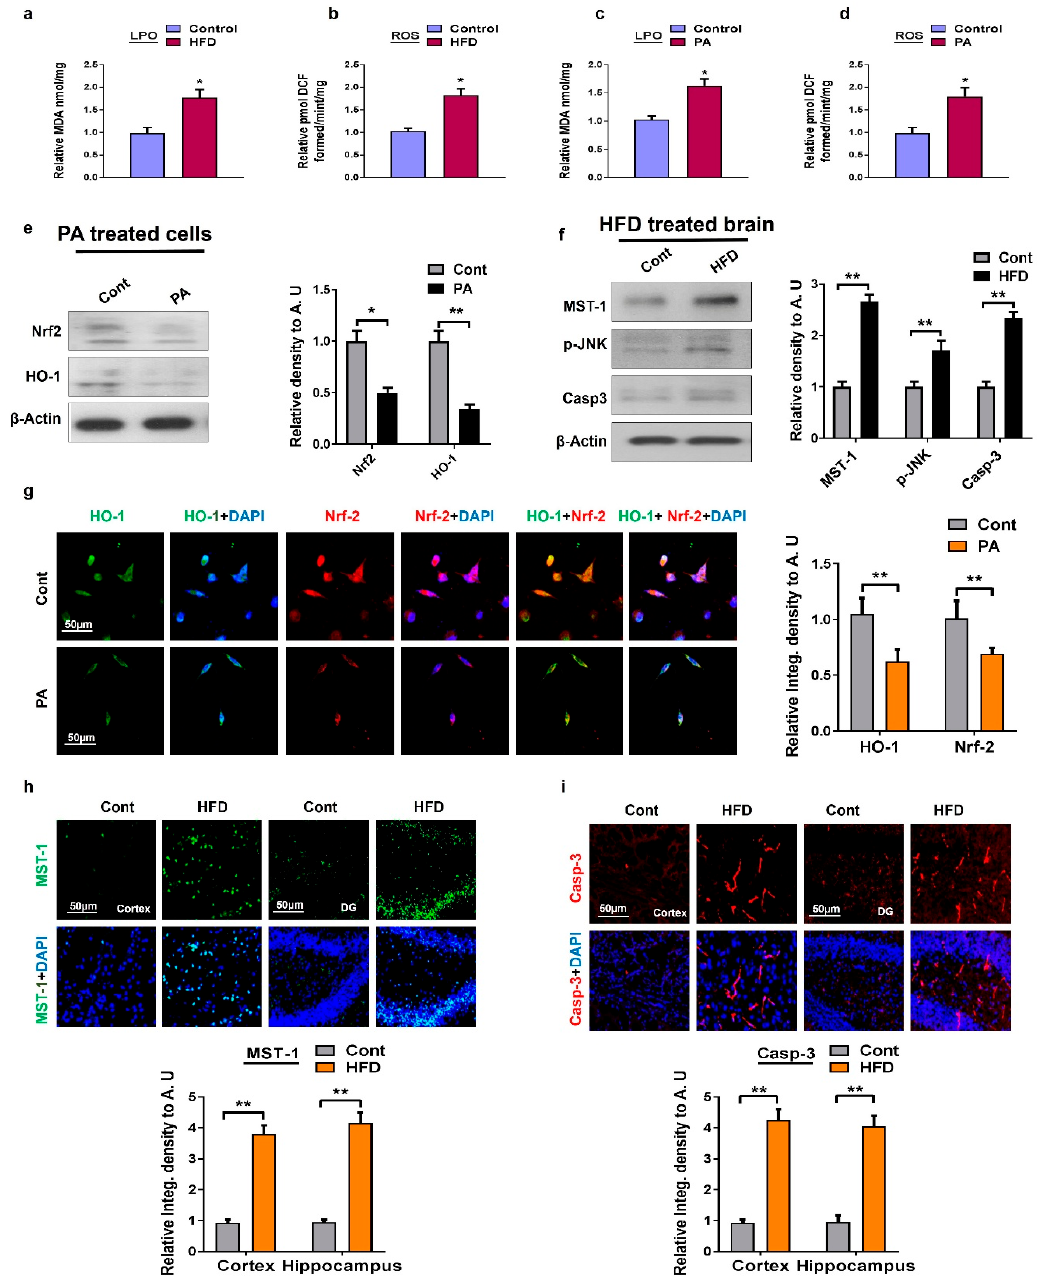
Figure 1. Metabolic dysregulation induced oxidative stress both in in vivo and in vitro models: ( a , b ) The histogram showing the results of lipid peroxidation (LPO) and reactive oxygen species (ROS) levels in the high-fat diet (HFD) mice model; ( c , d ) a histogram represent the results of LPO and ROS levels in palmitic acid treated HT22 cells; ( e ) shown are the Western blot results of nuclear factor-2 erythroid-2 (Nrf-2) and hemeoxygenase-1 (HO-1) along with respective histograms in the palmitic acid-treated HT22 cells. β -Actin was used as a loading control; ( f ) shown are the Western blot results of mammalian sterile 20-like kinase-1 (MST1), phosphor-c-Jun N-terminal Kinase (p-JNK), and Caspase-3 along with respective histograms in brain homogenates of HFD-fed mice and the normal control group. β -Actin was used as a loading control; ( g ) representative images of immunofluorescence staining of colocalization of Nrf2/HO-1 in palmitic acid-treated cells; ( h , i ) immunofluorescence staining images of MST1 and Casp-3 in mice cortex and the hippocampus region. n = 12 mice/group. The data are shown here as a mean ± SEM. * p < 0.05, ** p < 0.01.